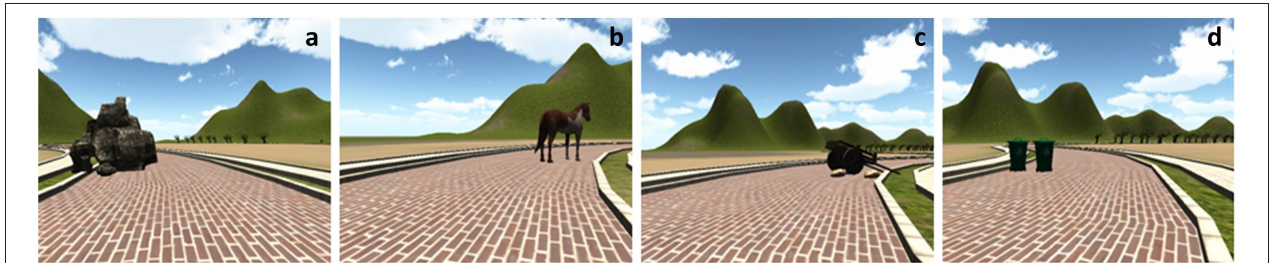
FIGURE 9 | Four task scenarios with various road curvatures and obstacles: (a) Task1, (b) Task2, (c) Task3, and (d) Task4.